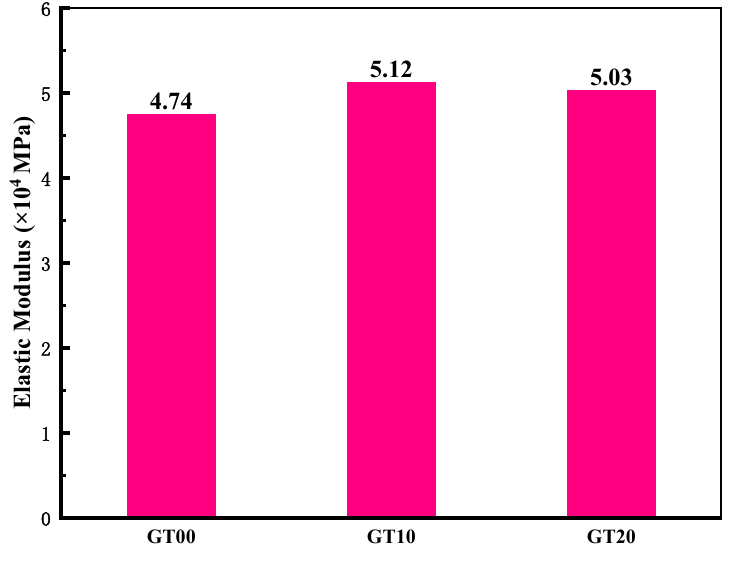
Figure 13. Compressive stress–strain curve.